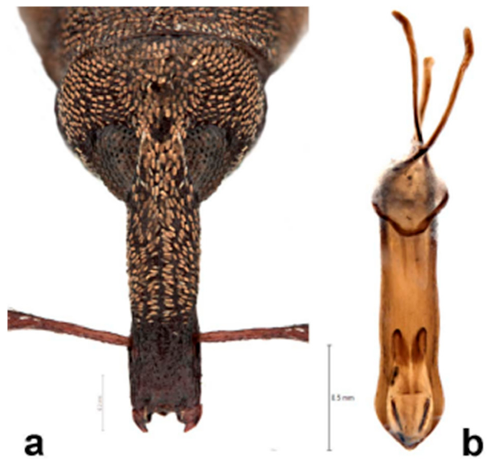
Figure 18. Imbilius araucariae : ( a ) habitus of male, dorsal aspect; ( b ) habitus of male, lateral aspect.